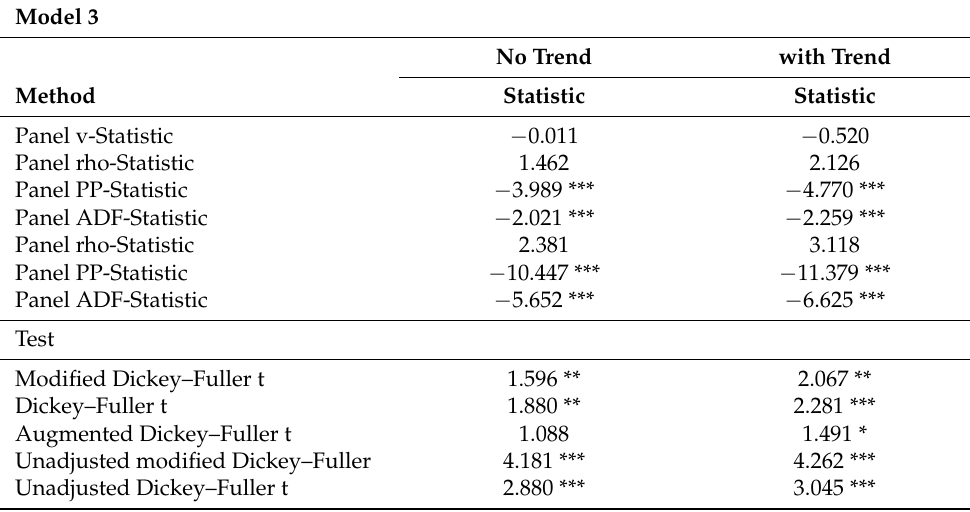
Table 10. Panel cointegration tests. Pedroni panel cointegration test and Kao Residual Cointegration for model 3.